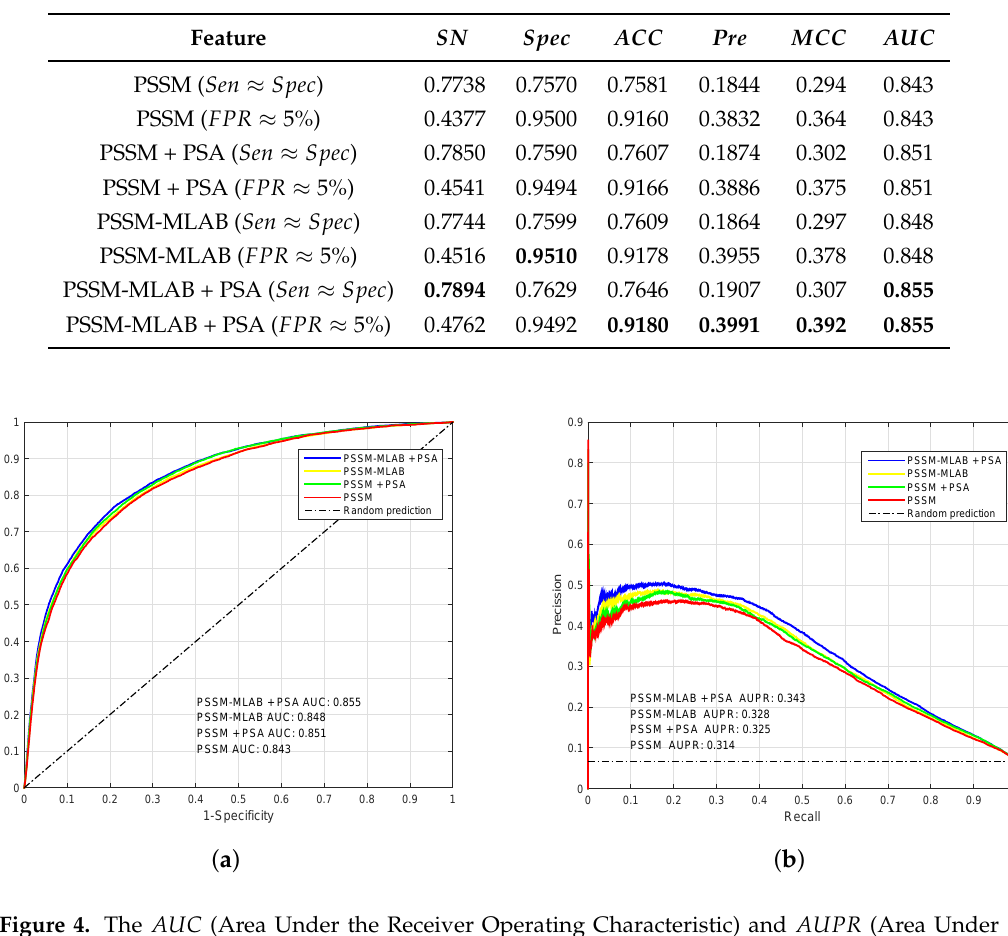
Table 2. The performance comparison of different features through ten-fold cross-validation by EC-RUS (Ensemble Classifier with Random Under-Sampling) (WSRC (Weighted Sparse Representation based Classifier), Equation (16)) on PDNA-543 dataset.